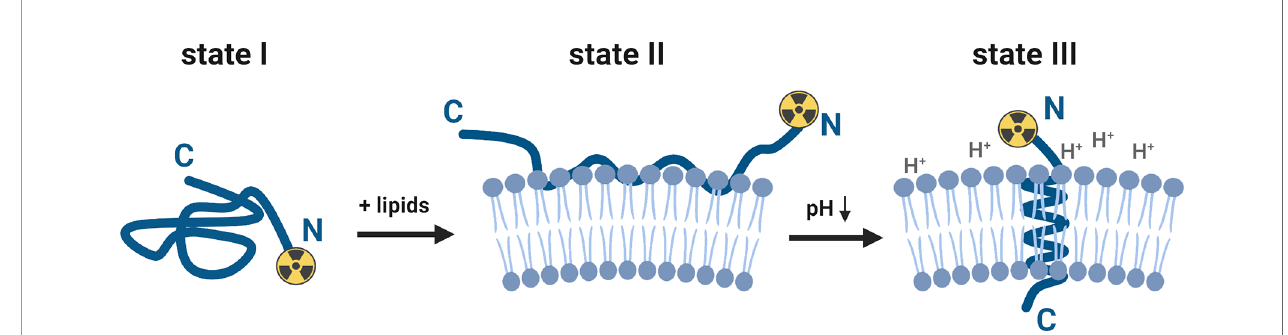
FIGURE 1 | Schematic presentation of the interaction of a pHLIP-cargo conjugate with the lipid bilayer of a membrane at neutral/high and low pH values (for purpose of this study, the cargo represents a [ 89 Zr]zirconium-chelate, attached to the N-terminus). The pHLIP sequence is an unstructured coil in the solution at neutral and high pH values (state I). The equilibrium shifts towards the membrane-bound state II when lipids (e.g., cell membranes) are added to the system. At a low surface pH (6.0 – 6.2), aspartic acid and glutamic acid residues are protonated and the overall hydrophobicity increases. This triggers the partitioning of the peptide into the lipid bilayer. The equilibrium at low pH values is shifted towards the membrane-inserted state III, which is accompanied by membrane-associated folding to form a transmembrane alpha-helix. This fi gure was created with